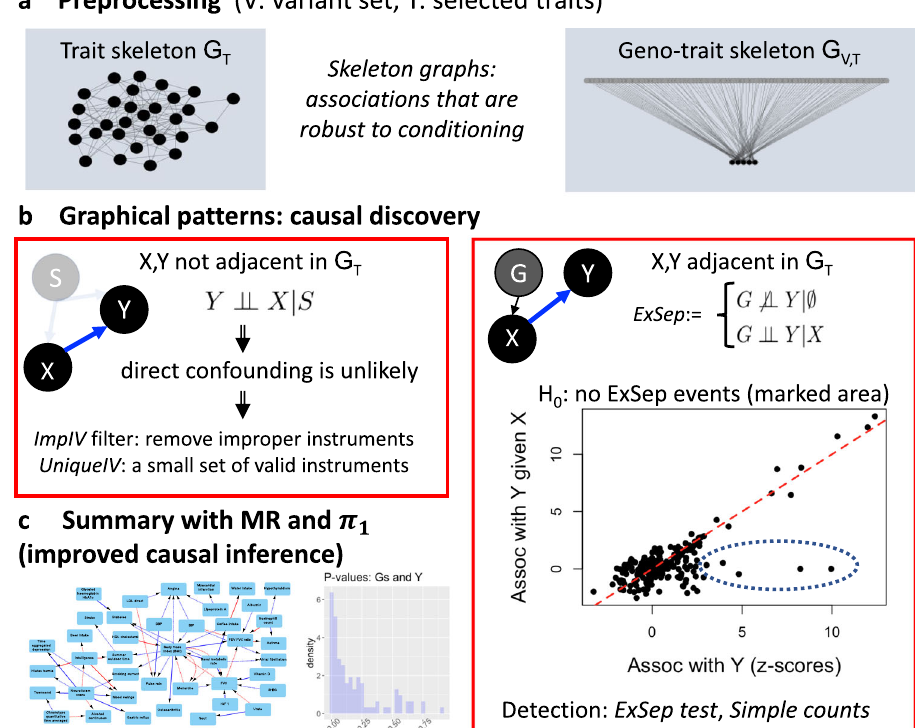
Fig. 1 The cGAUGE work fl ow for causal discovery. We analyze genetic and phenotypic data collected from independent subjects. a We fi rst preprocess the data to infer skeleton graphs: graphs that represent associations that are robust to conditioning. Based on causal inference theory 1,2 , surviving associations contain the subset of true causal links. We learn two skeletons: G T among the phenotypes (ignoring the genetic data in the process), and G V,T between the variants and the phenotypes. b We then analyze the edges and the non-edges of G T separately. We present methods that use G V,T to fi lter out improper instruments (ImpIV) or identify unique proper instruments (UniqueIV). While their theoretical justi fi cation is pertinent to G T non-edges, we illustrate using simulations how they reduce the empirical FDR when applied to all phenotype pairs. For G T edges we present an analysis based on ExSep events: associations between genetic variables and a trait Y that “ disappear ” once conditioned on a new phenotype X (i.e., p > p 2 ). Under our local faithfulness assumption these patterns are evidence for a causal link from X to Y . The ExSep model selection test is a method to analyze all genetic variables under the null hypothesis of no ExSep events. c Finally, we utilize our results for improved inference using Mendelian Randomization (MR) and also utilize the π 1 estimate for each exposure – outcome pair. This score quanti fi es the consistency of the associations between the exposure ’ s instruments and the outcome, which can be used to fl ag potential false positive causal